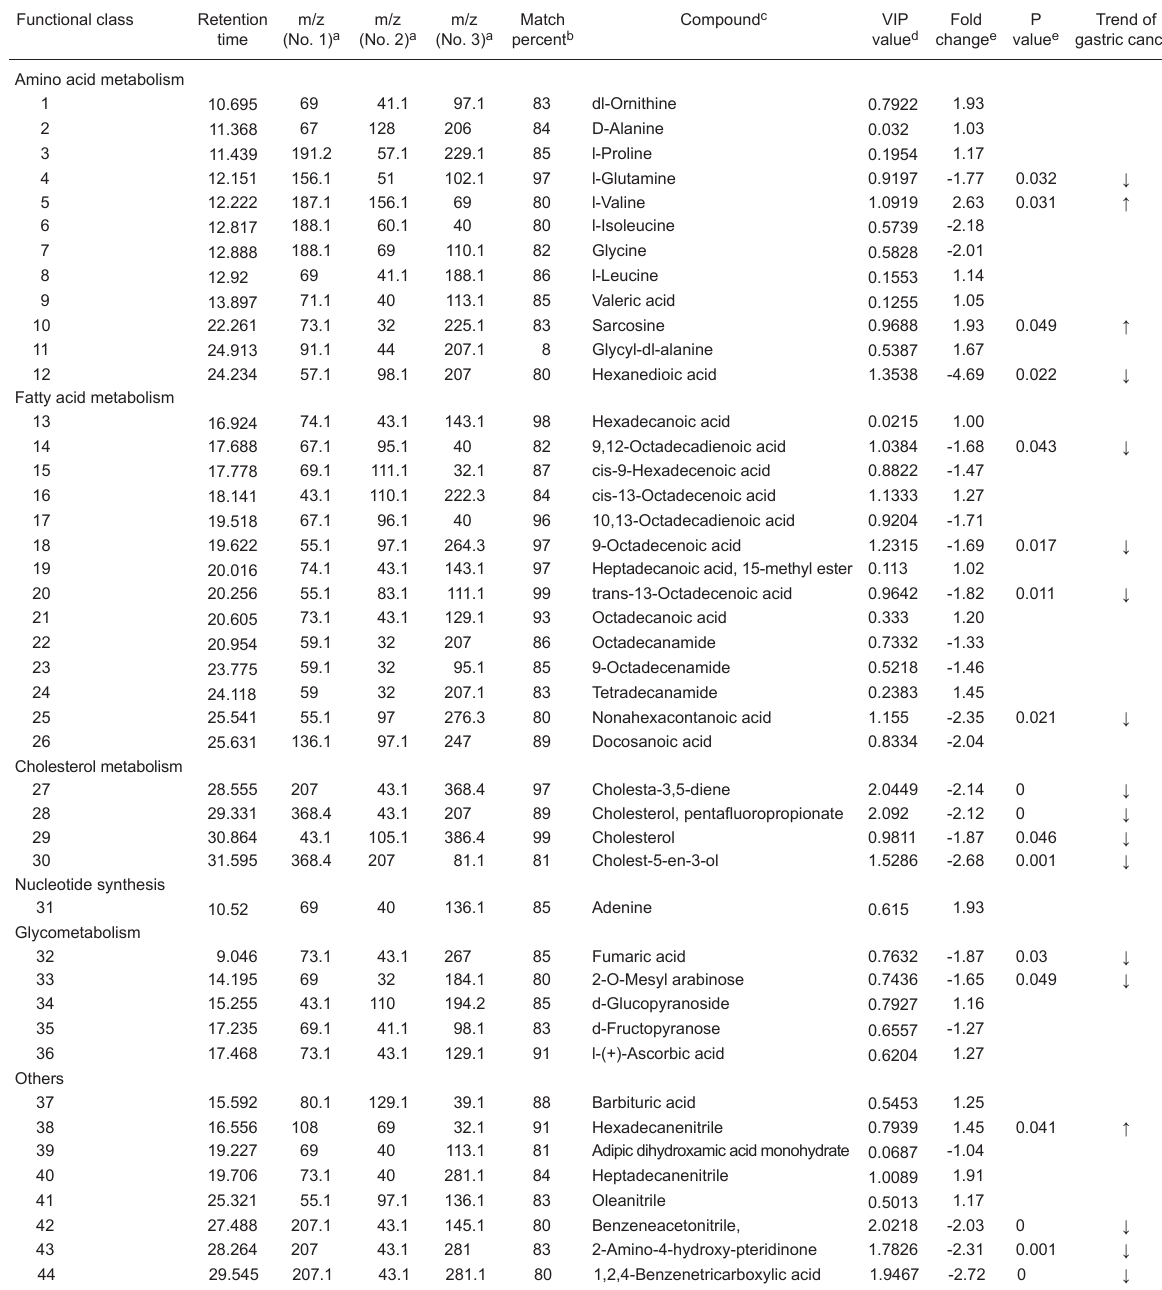
Table 2. Serum differential metabolites derived from gas chromatography/mass spectrometry analysis. Functional